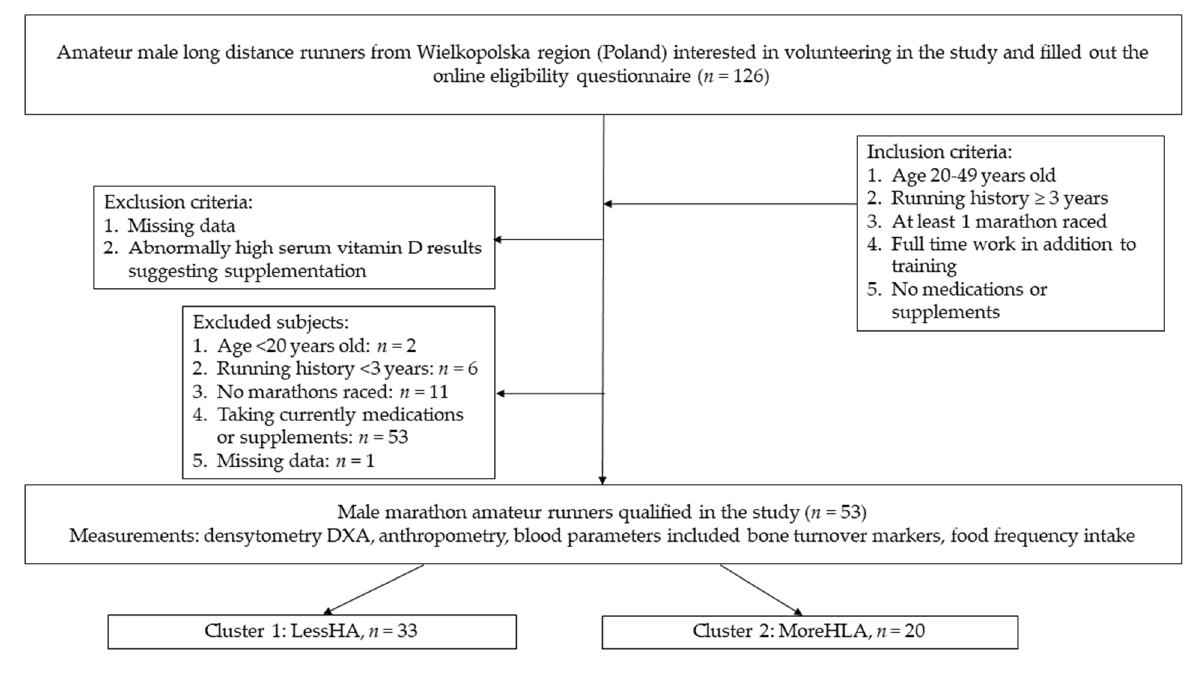
Figure 1. Study recruitment flowchart.